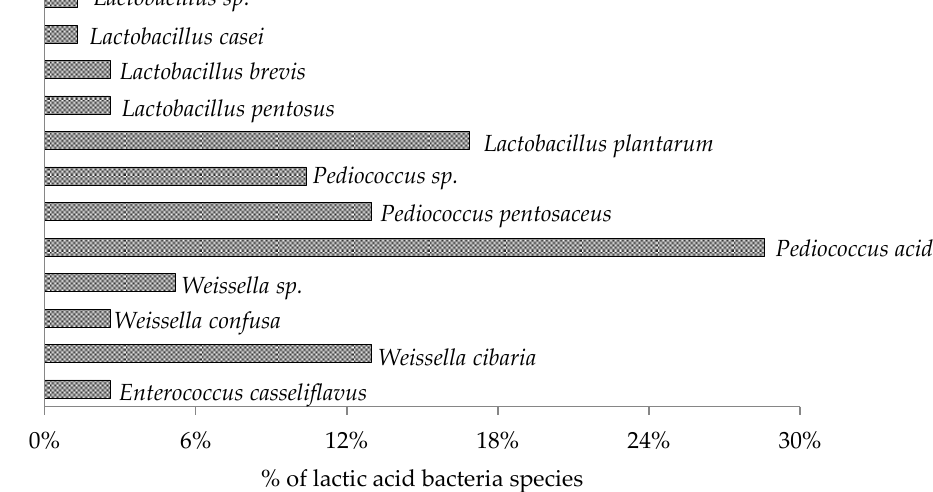
Figure 2. Frequency of lactic acid species isolated from alfalfa silage through the fermentation period (56 days).